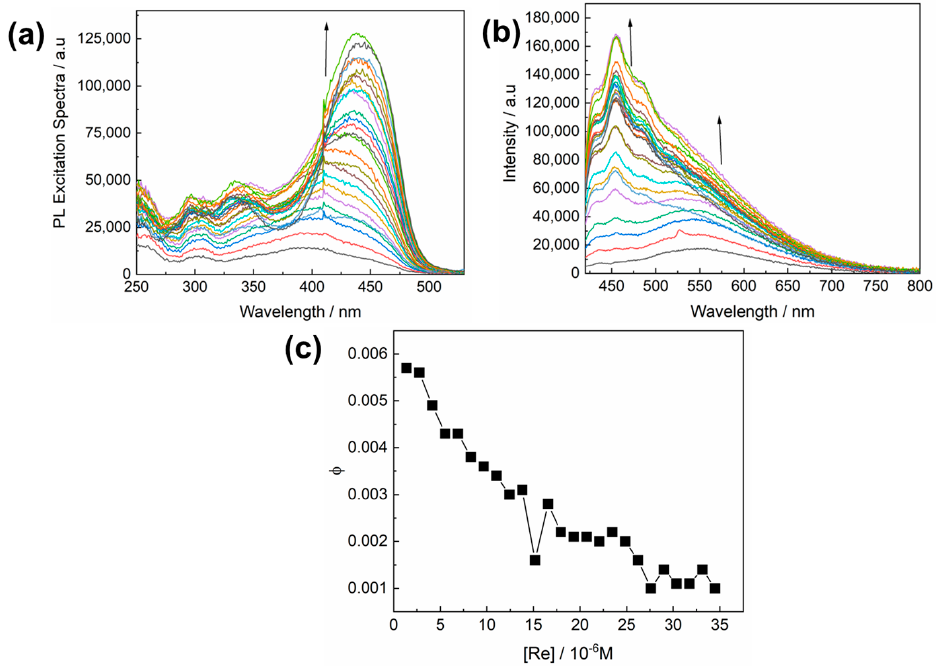
Figure 3. Concentration-dependent excitation spectra ( λ em = 500 nm) ( a ), emission spectra ( λ ex = 400 nm) ( b ) and a plot ( c ) of emission quantum yield vs. concentrations of [Re(CO) 3 Cl(L)] in DCM (1.38–34.5 μ M). Note: arrows indicate the spectral changes upon increasing concentrations.